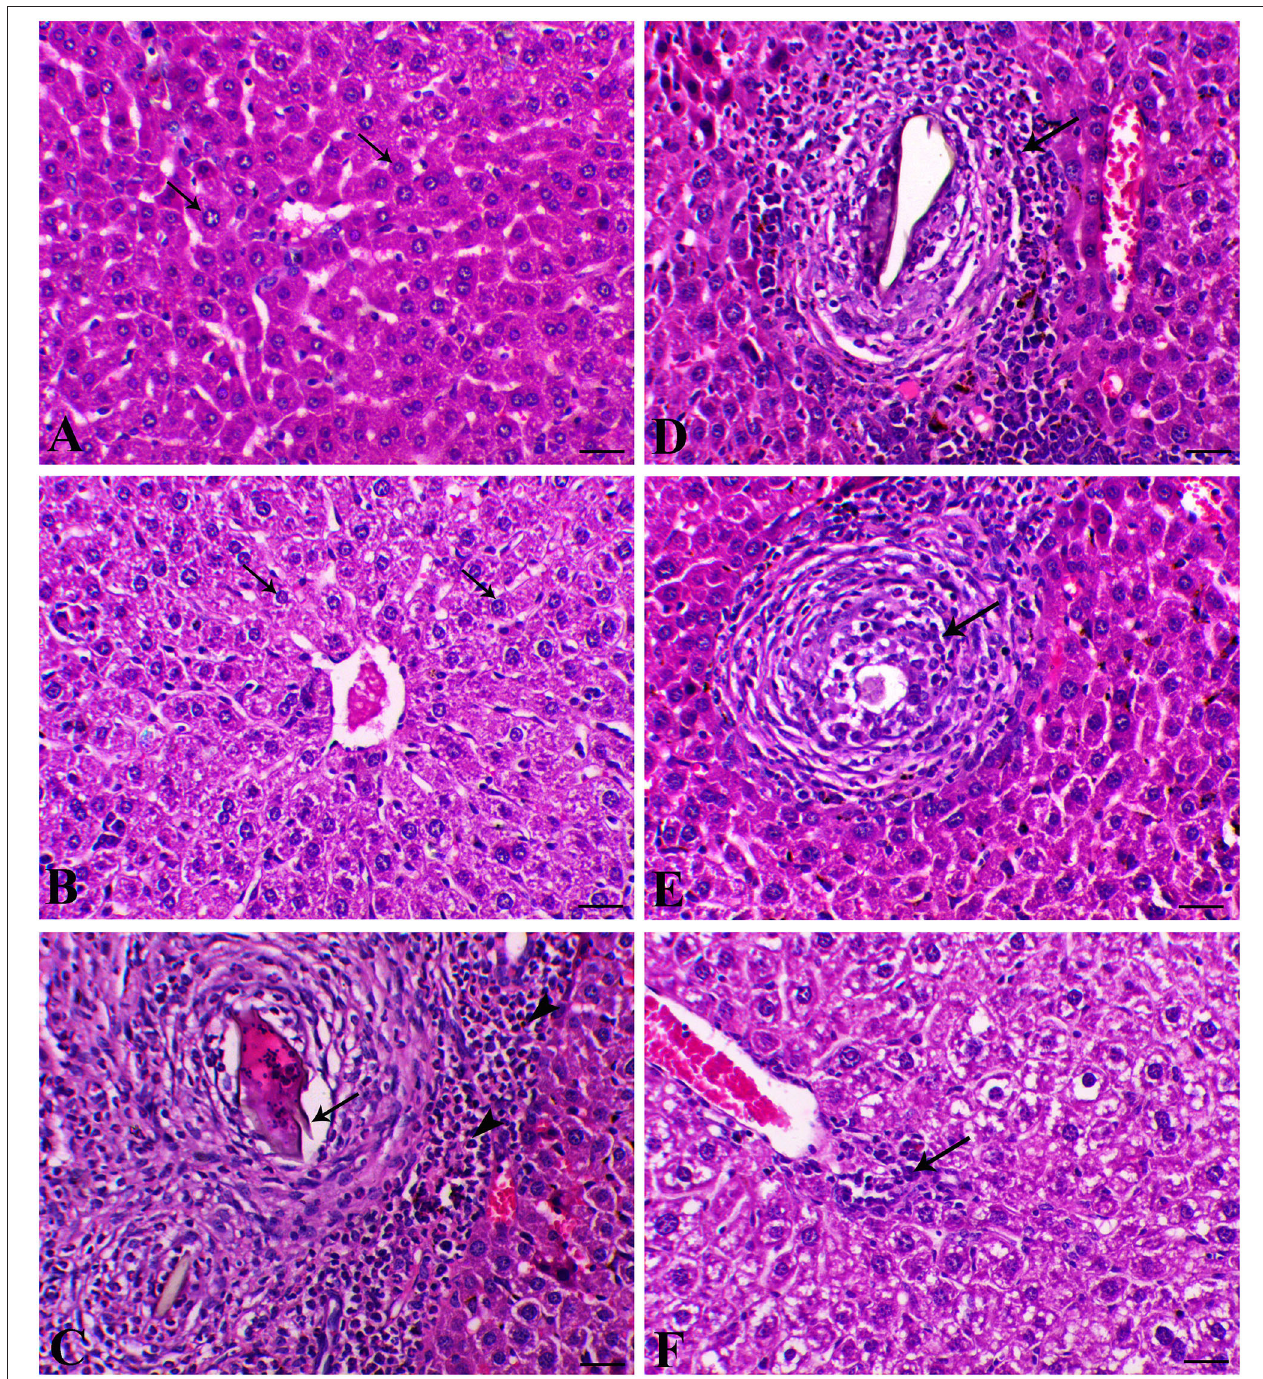
FIGURE 5 | Hepatic histological sections of control group (A) (arrows indicate normal polygonal hepatic cell with central vesicular nucleus), SP–MGT (B) (arrows indicate normal hepatocytes), Infected group (C) (arrow indicates the schistosome egg, which revealing lateral spine, arrowheads indicates eosinophils), SP-infected group (D) (arrow indicates small-sized granuloma), MTG-infected group (E) (arrow indicates small-sized granuloma), and SP + MGT-infected group (F) (arrow indicates mild lymphocytic cells infiltration). granuloma and fibrosis after S. japonicum infection and macrophage expansion, and apoptosis (85). In addition, IL- other mediators (IL-13 and tissue transglutaminases) has been 10 plays an important role in the modulation of cytokine reported (65). Silveira-Lemos et al. (84) also revealed networks in schistosomiasis. The association between hepatic